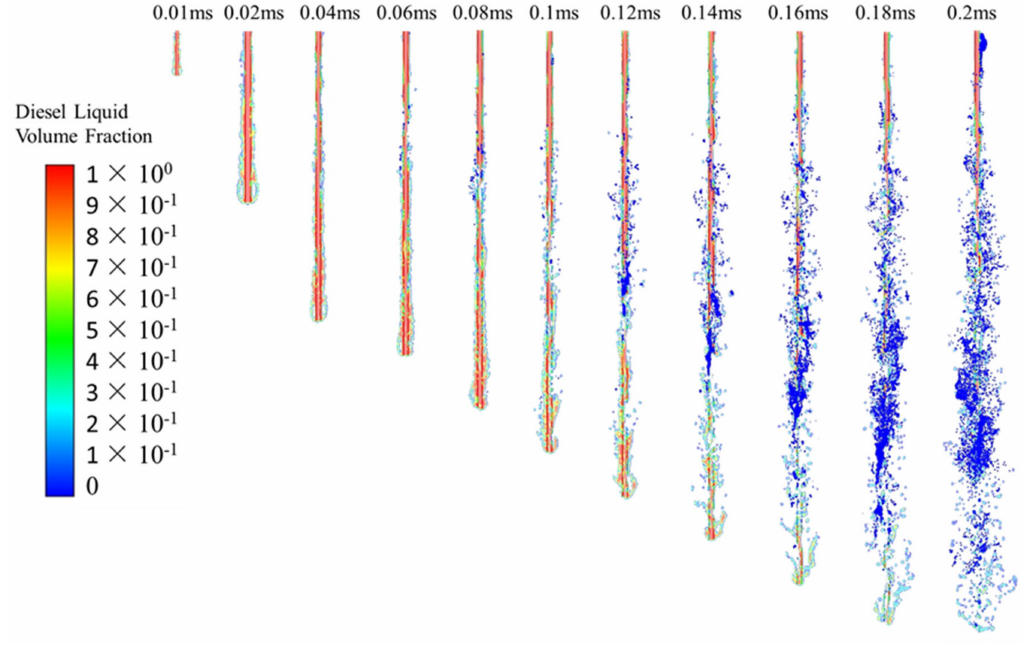
Figure 10. Fuel spray process in center plane. ( p injection = 100 MPa, p b = 1 MPa).